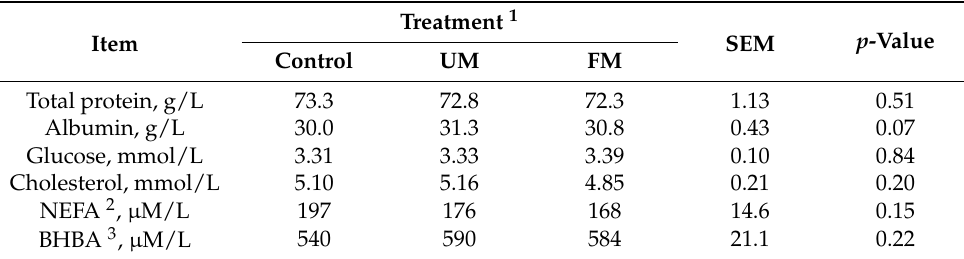
Table 5. Plasma metabolites in dairy cows fed the experimental total mixed rations (TMR) containing unfermented (UM) and fermented yellow wine lees mix